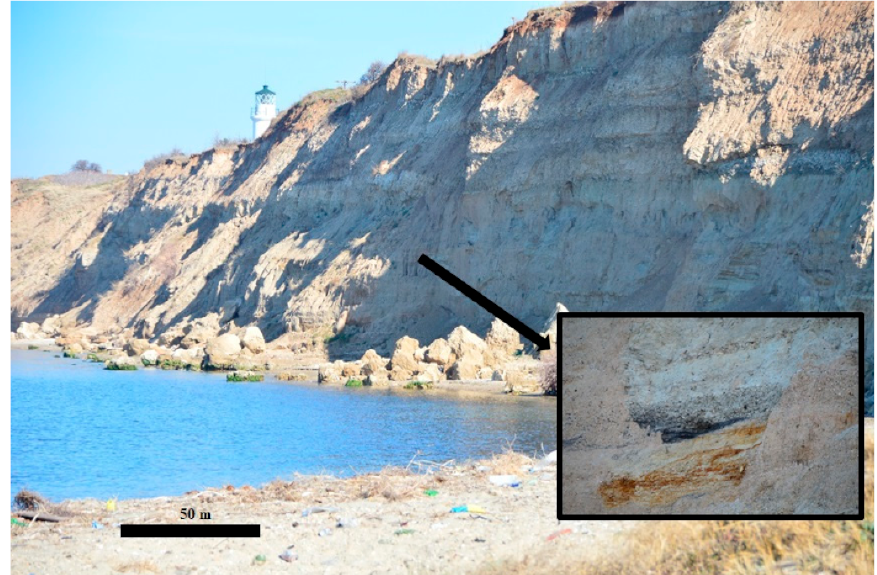
Figure 2. The sampled cliff and the black sand